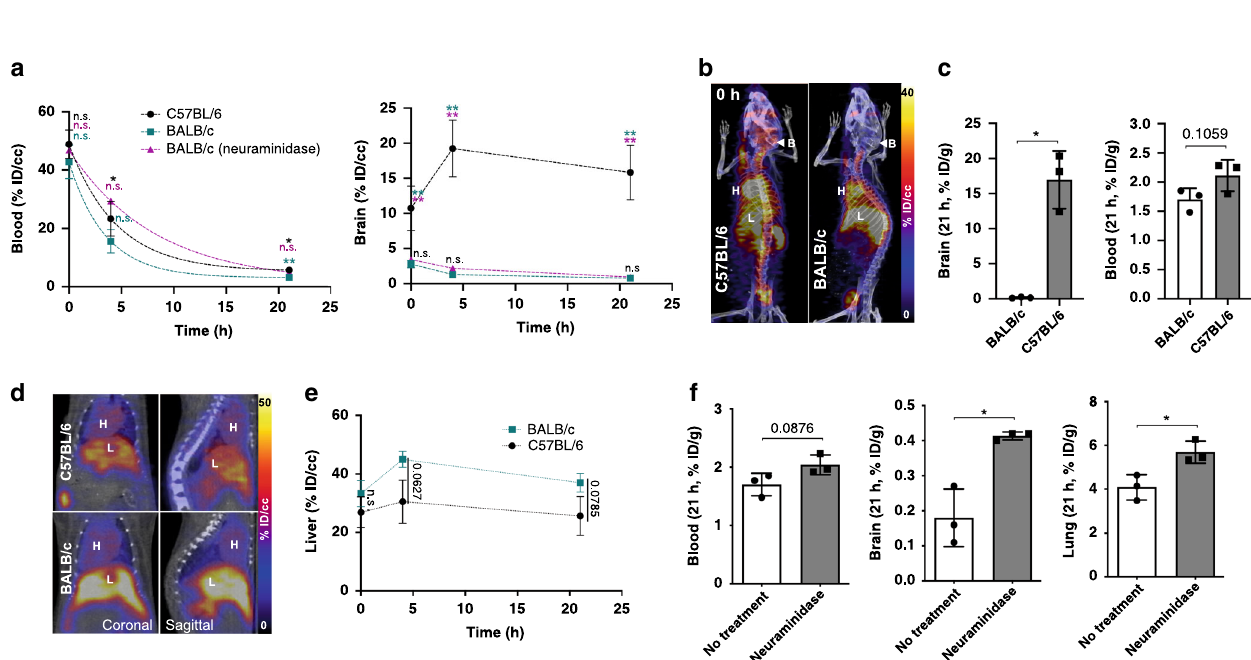
Fig. 4 Strain and neuraminidase-dependent pharmacokinetics of 64 Cu-PHP.eB. a Time activity curves of PHP.eB obtained from region of interest (ROI) analysis of blood (left) and brain (right) from C57BL/6 (black circle), BALB/c (turquoise square), and neuraminidase-treated BALB/c (magenta triangle) mice over 21 h ( n = 3 per group). Radioactivity from ROI analysis is presented as % ID/cc. b Representative PET/CT projection images (B brain, H heart, L liver) acquired over 30 min after tail vein injection of 64 Cu-PHP.eB to C57BL/6 and BALB/c mice. c Biodistribution (% ID/g) of 64 Cu-PHP.eB in brain (left) and blood (right) in C57BL/6 (gray bar with black squares) and BALB/c (white bar with black circle) mice at 21 h ( n = 3). d Sliced PET/CT image (H heart, L liver) at 4 h after tail vein injection of 64 Cu-PHP.eB. e Time activity curve of 64 Cu-PHP.eB measured from C57BL/6 (black circle) and BALB/c (turquoise square) livers ( n = 3). f Biodistribution (21 h) of 64 Cu-PHP.eB in blood (left), brain (middle), and lung (right) from BALB/c with no treatment white bar with black circle) versus BALB/c mice treated with neuraminidase (gray bar with black square) ( n = 3). Data are shown as mean ± SD. For statistical analysis, a one-way ANOVA with Tukey ’ s multiple comparison test in a was performed to compare means of three groups (C57BL/6 vs BALB/c: turquoise,